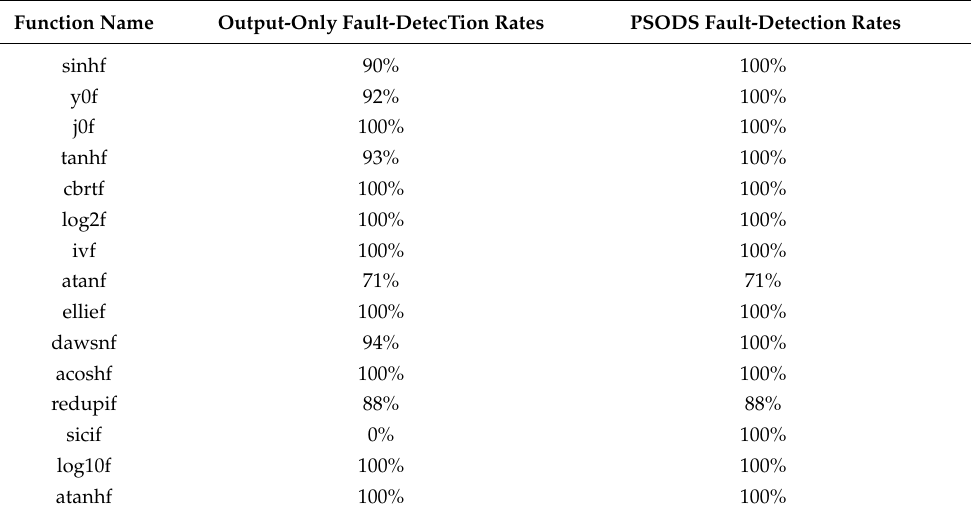
Table 4. Fault-detection Rates of Selected